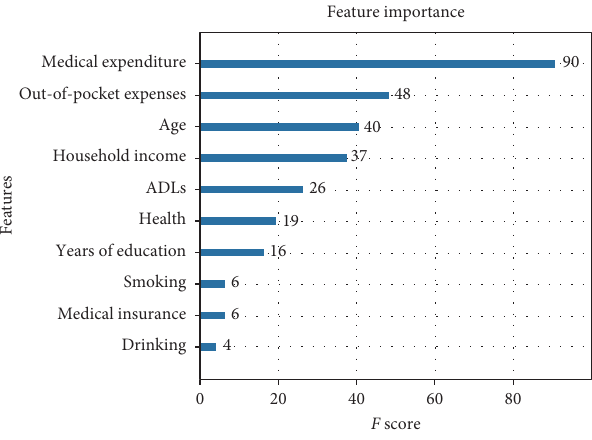
Figure 4: Importance ranking of impact factors.